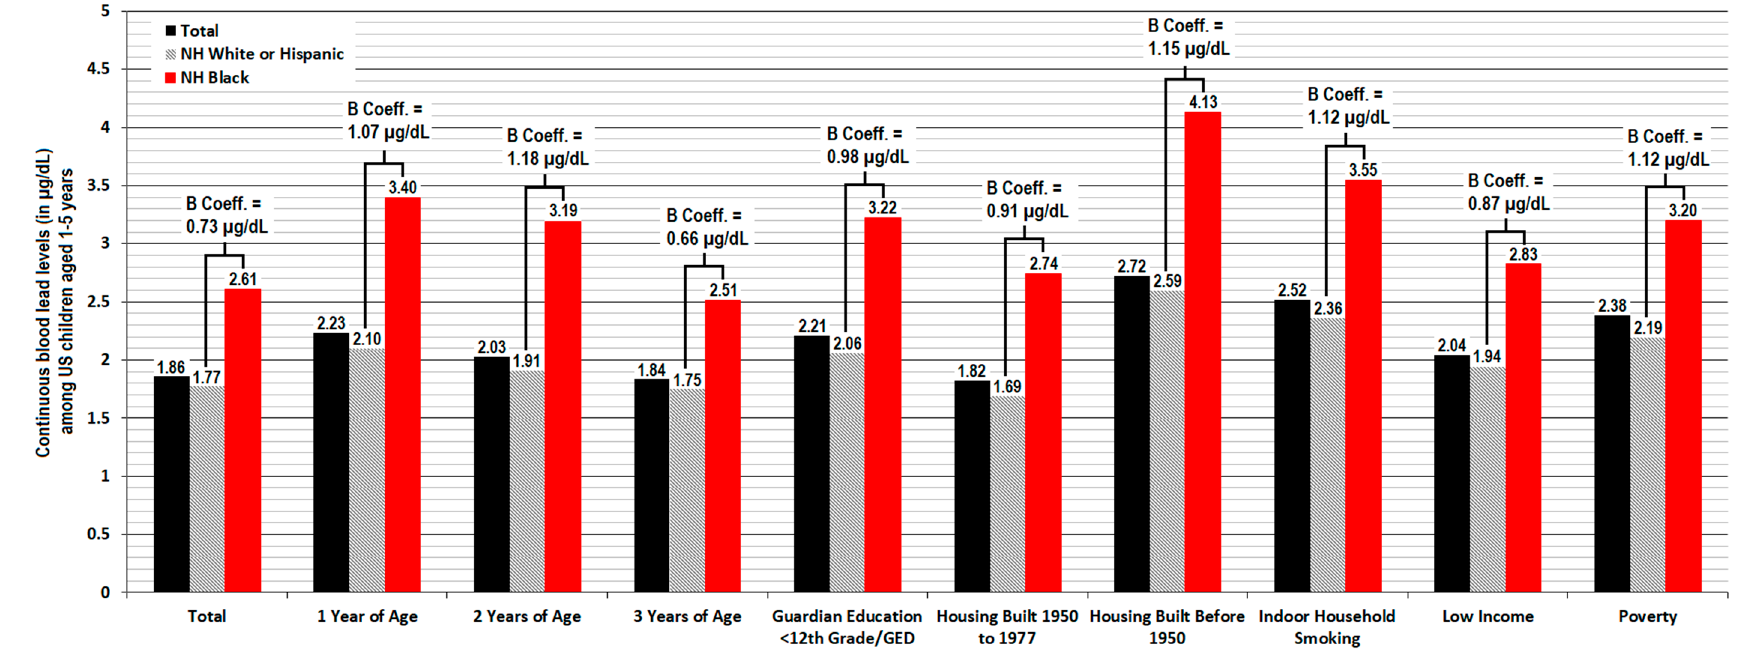
Figure 2. Weighted estimates of means and adjusted unstandardized coefficients for continuous blood lead levels (BLLs) within the general US population or risk factor groups among children 1–5 years of age with US citizenship—the 1999 to 2010 NHANES.